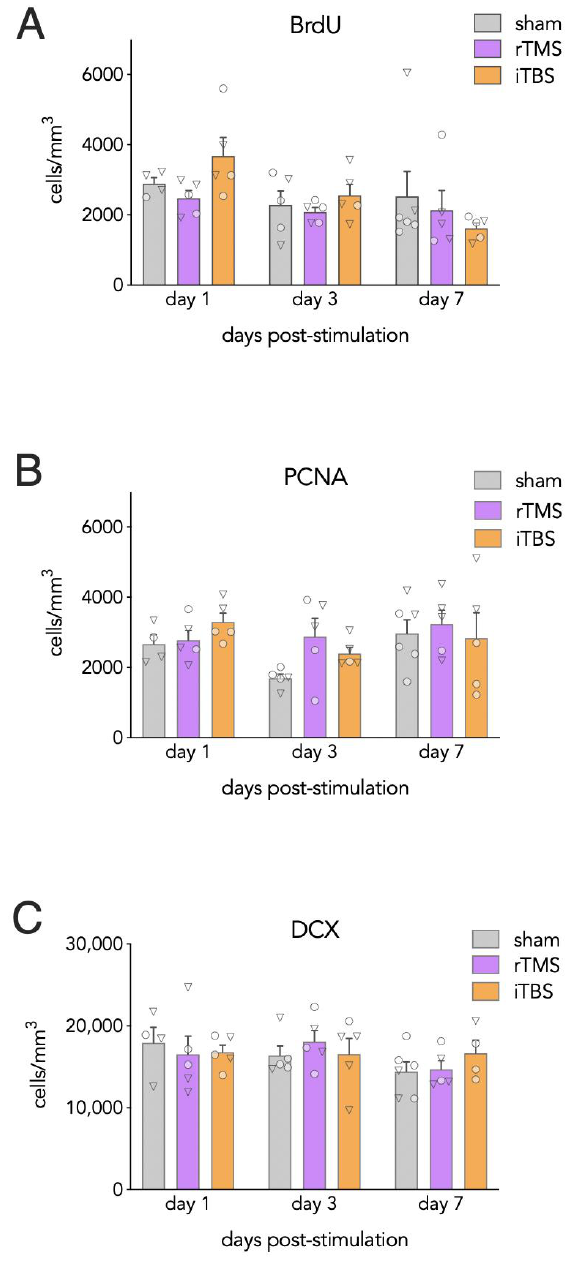
Figure 3. Time course of neurogenesis following one session of rTMS and iTBS. ( A ) Neither stimula- tion treatment altered the survival of BrdU + cells relative to shams. ( B ) The density of proliferating PCNA + cells was not altered by rTMS or iTBS treatments. ( C ) The density of proliferating immature DCX + cells was not altered by rTMS or iTBS treatments. Bars reflect mean ± standard error. Triangles indicate female mice; circles indicate male